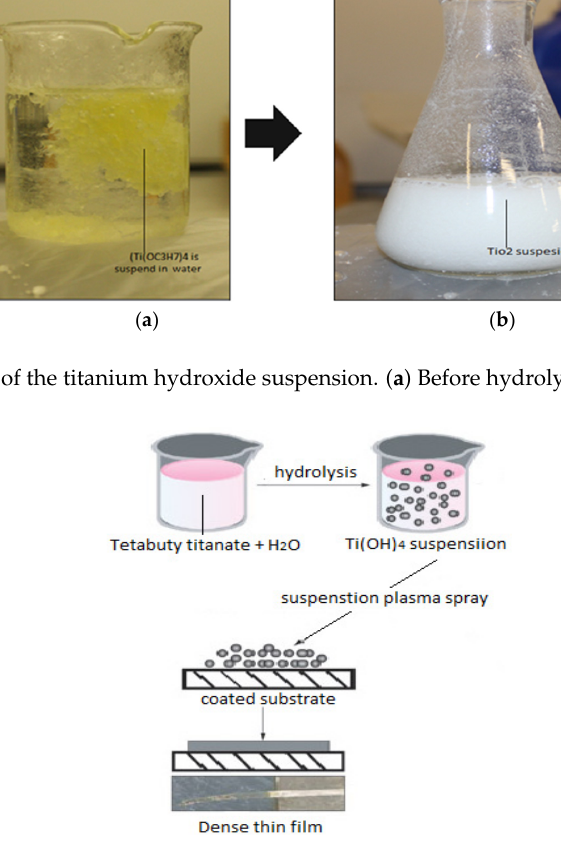
Figure 2. Illustration of the estimated film deposition mechanism in this suspension plasma spray (SPS) process.